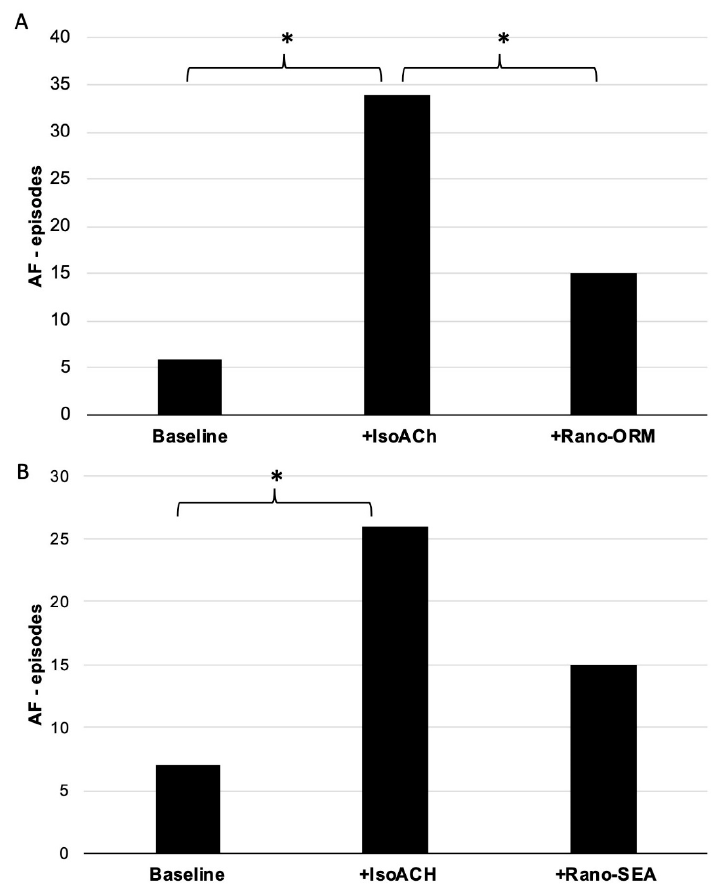
Figure 3. ( A ) total number of induced episodes of atrial fibrillation (AF) under baseline conditions and after perfusion with isoproterenol/acetylcholine and with ranolazine/ORM-10103 ( n = 9) (*: p < 0.05). ( B ) total number of induced episodes of atrial fibrillation under baseline conditions and after perfusion with isoproterenol/acetylcholine and with ranolazine/SEA0400 ( n = 9) (*: p < 0.05).